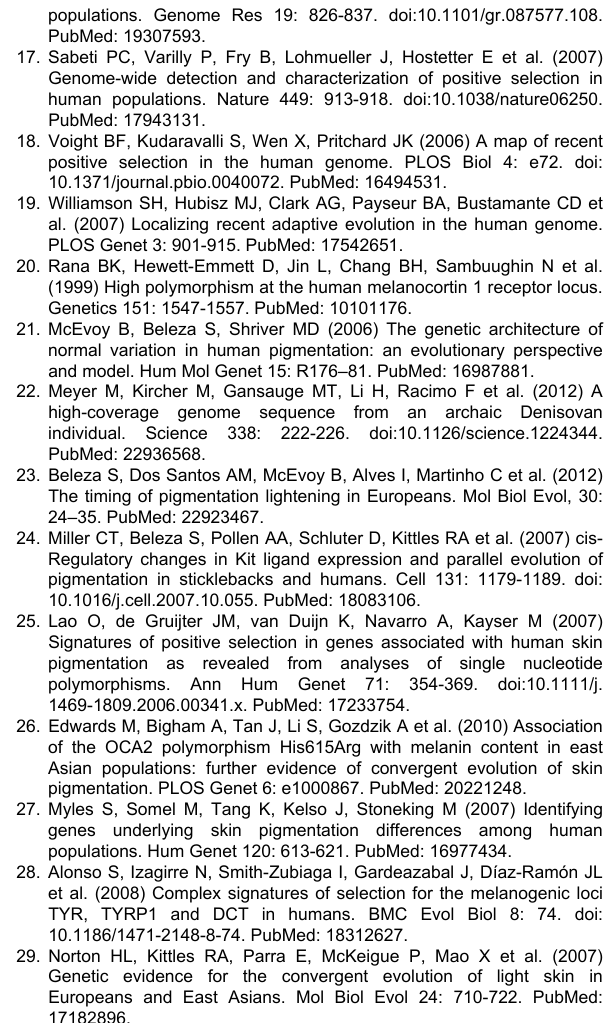
Table S6. Frequency and 95% confidence intervals of 18 haplogroups detected from the Illumina genotyping dataset. Haplogroup frequencies and 95% confidence intervals within the studied (sub-) continental groups are